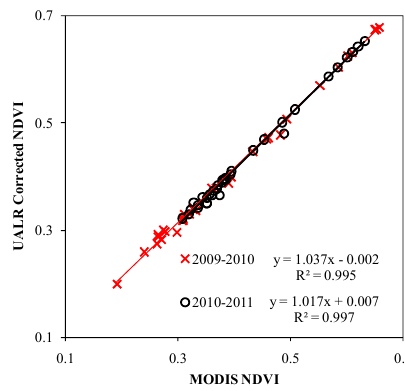
Figure 6. Relationship between spatially-averaged MODIS NDVI and UALR-adjusted NDVI for 2010 and 2011.